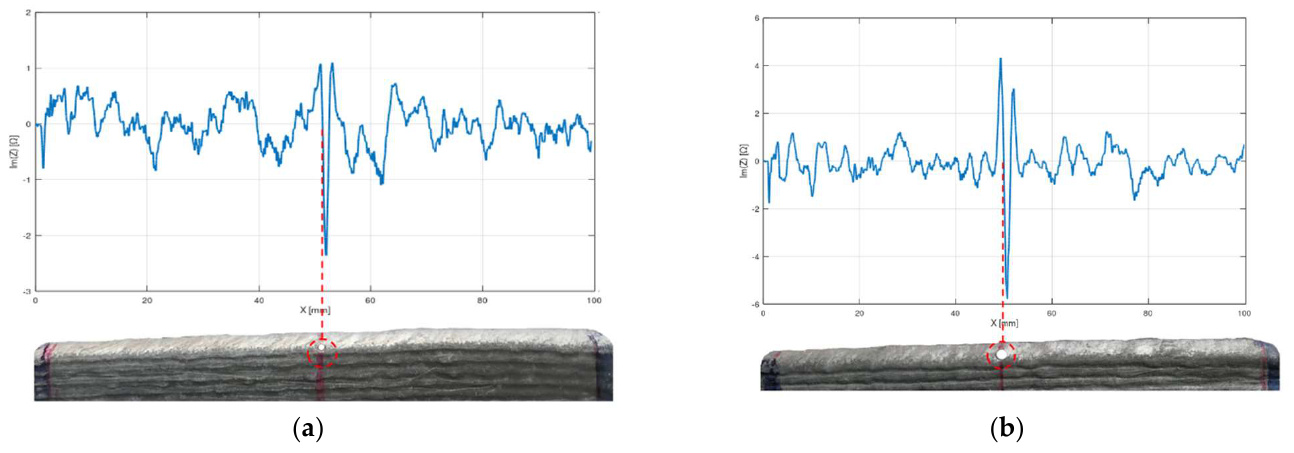
Figure 23. Multi-layer flexible PCB probe impedance output obtained from the inspection of an aluminum sample at a frequency of 1.5 kHz with: ( a ) a 1 mm diameter defect; ( b ) a 1.5 mm diameter defect.